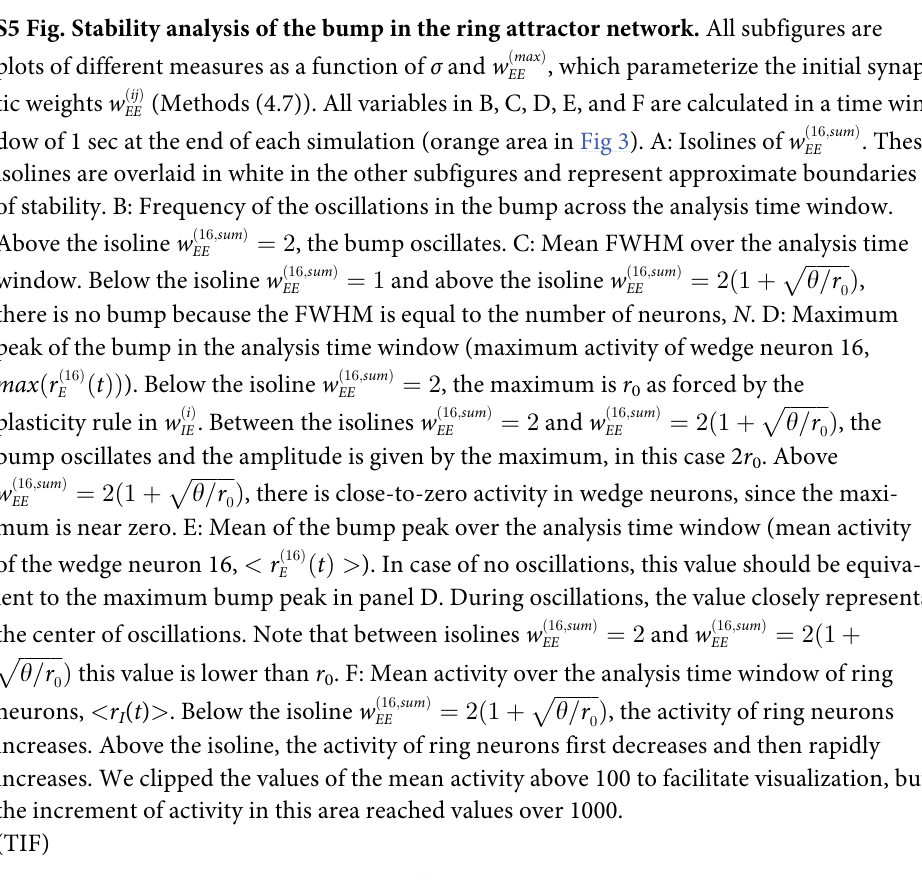
with larger σ . C: Same as A, B but again increasing σ . In this simulation, the bump shows stable oscillations. S5 Fig. Stability analysis of the bump in the ring attractor network. All subfigures are plots of different measures as a function of σ and w ð max Þ , which parameterize the initial synap- EE tic weights w ð ij Þ (Methods (4.7)). All variables in B, C, D, E, and F are calculated in a time win- EE dow of 1 sec at the end of each simulation (orange area in Fig 3). A: Isolines of w ð 16 ; sum Þ . These EE isolines are overlaid in white in the other subfigures and represent approximate boundaries of stability. B: Frequency of the oscillations in the bump across the analysis time window. Above the isoline w ð 16 ; sum Þ ¼ 2 , the bump oscillates. C: Mean FWHM over the analysis time EE ffiffiffiffiffiffiffiffiffi p window. Below the isoline w ð 16 ; sum Þ ¼ 1 and above the isoline w ð 16 ; sum Þ ¼ 2 ð 1 þ y = r Þ , 0 EE EE there is no bump because the FWHM is equal to the number of neurons, N . D: Maximum peak of the bump in the analysis time window (maximum activity of wedge neuron 16, ð t ÞÞ ). Below the isoline w ð 16 ; sum Þ ¼ 2 , the maximum is r as forced by the max ð r ð 16 Þ 0 E EE p ffiffiffiffiffiffiffiffiffi Þ , the plasticity rule in w ð i Þ . Between the isolines w ð 16 ; sum Þ ¼ 2 and w ð 16 ; sum Þ ¼ 2 ð 1 þ y = r 0 IE EE EE bump oscillates and the amplitude is given by the maximum, in this case 2 r . Above 0 ffiffiffiffiffiffiffiffiffi p y = r Þ , there is close-to-zero activity in wedge neurons, since the maxi- w ð 16 ; sum Þ 0 EE mum is near zero. E: Mean of the bump peak over the analysis time window (mean activity of the wedge neuron 16, < r ð 16 Þ ð t Þ > ). In case of no oscillations, this value should be equiva- E lent to the maximum bump peak in panel D. During oscillations, the value closely represents the center of oscillations. Note that between isolines w ð 16 ; sum Þ ¼ 2 and w ð 16 ; sum Þ ¼ 2 ð 1 þ EE EE ffiffiffiffiffiffiffiffiffi p y = r Þ this value is lower than r . F: Mean activity over the analysis time window of ring 0 0 p ffiffiffiffiffiffiffiffiffi Þ , the activity of ring neurons neurons, < r ( t ) > . Below the isoline w ð 16 ; sum Þ ¼ 2 ð 1 þ y = r I 0 EE increases. Above the isoline, the activity of ring neurons first decreases and then rapidly increases. We clipped the values of the mean activity above 100 to facilitate visualization, but the increment of activity in this area reached values over 1000. S6 Fig. Values of the synaptic weights w ð ij Þ in the simulation of Fig 4. From left to right EE and from top to bottom: each plot shows the values each time there is a switch between wake and sleep phase and vice versa . Top, left: initial values of the weights set by the initial values of w ð max Þ and σ in Table B in S1 Text. Top, center left: weights at the end of the first wake EE phase. Top, center right: after the subsequent sleep phase. Top, right: after the second wake phase. Bottom, left: weights after the second sleep phase. Bottom, center left: after sleep dep- rivation. Bottom, center right: after sleep rebound. Bottom, right: weights after the third wake phase. Note how the weights after each wake phase are increased (specially after sleep deprivation in the sixth plot) and how the sleep phase resets the weights to close to the initial conditions. S7 Fig. Simulation of the ring attractor network with flashing input during the wake phase with slow plasticity time constants (details in Methods(4.9)). The time constants τ and τ EE IE in this simulation are 210 times larger than in Table B in S1 Text. We decreased the time reso- lution of the simulation (time step is 0.001 seconds) and decreased the value r ð max Þ to 30. A: I Full simulation with three wake phases and three sleep phases. We used the same input rota- tion as in Fig 5 (rotating input at 0.5 Hz ). B: Blow-up around 70 minutes in the first wake phase of the simulation. C: Blow-up around 220 seconds in the second wake phase. D: